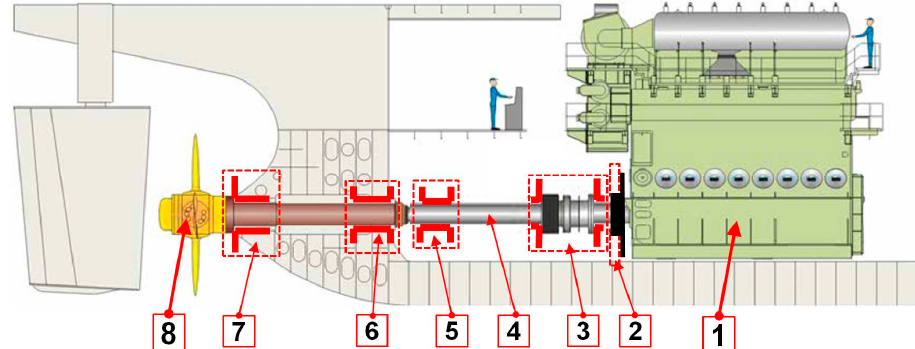
Figure 2. Sample diagram of the main propulsion system of the ship: 1—marine low-speed, two- stroke internal combustion main engine (ME), winged and slow-running; 2—non-disconnectable hydraulic coupling; 3—thrust bearing; 4—intermediate shaft; 5—bearing of intermediate shaft; 6—bearing of screw shaft; 7—scabbard of screw shaft; 8—fixed pitch propeller (own elaboration using MAN BW drive drawing [30]).